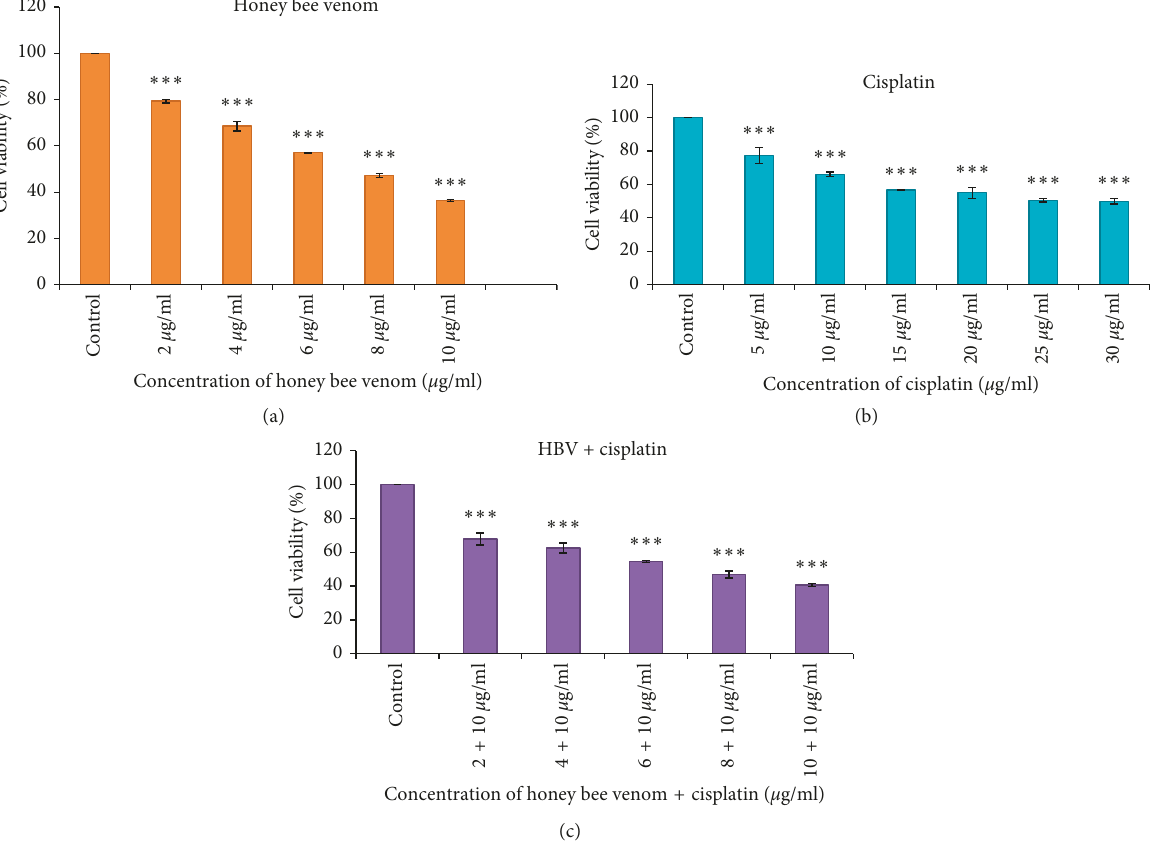
Figure 1: The cell viability percentages of a treated 4T1 cell line with various concentrations of HBV (a), cisplatin (b), and HBV/cisplatin (c) after 24h by MTT staining (mean ± SEM, ∗∗∗ p < 0 . 001). HBV: honey bee venom.